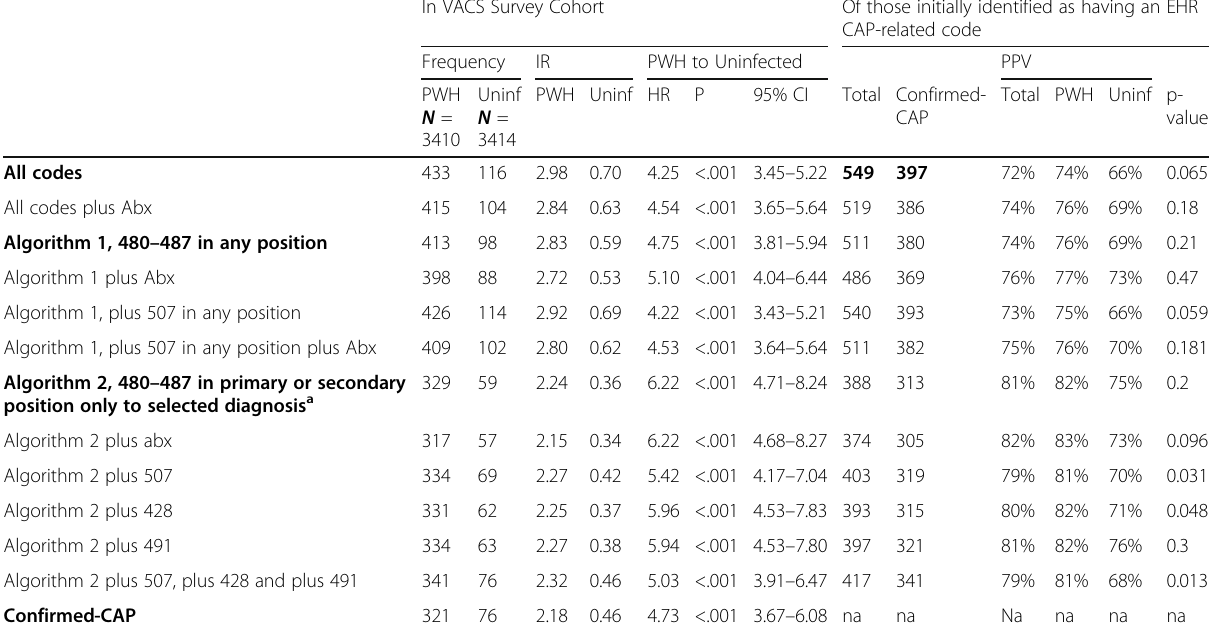
Table 3 Incidence Rates (IR) and Hazard Ratios (HR) for community-acquired pneumonia (CAP) identified in electronic health records (EHR) by ICD-9 codes and restricted to those with confirmed CAP by chart review (confirmed-CAP) in PWH and HIV- uninfected (Uninf)